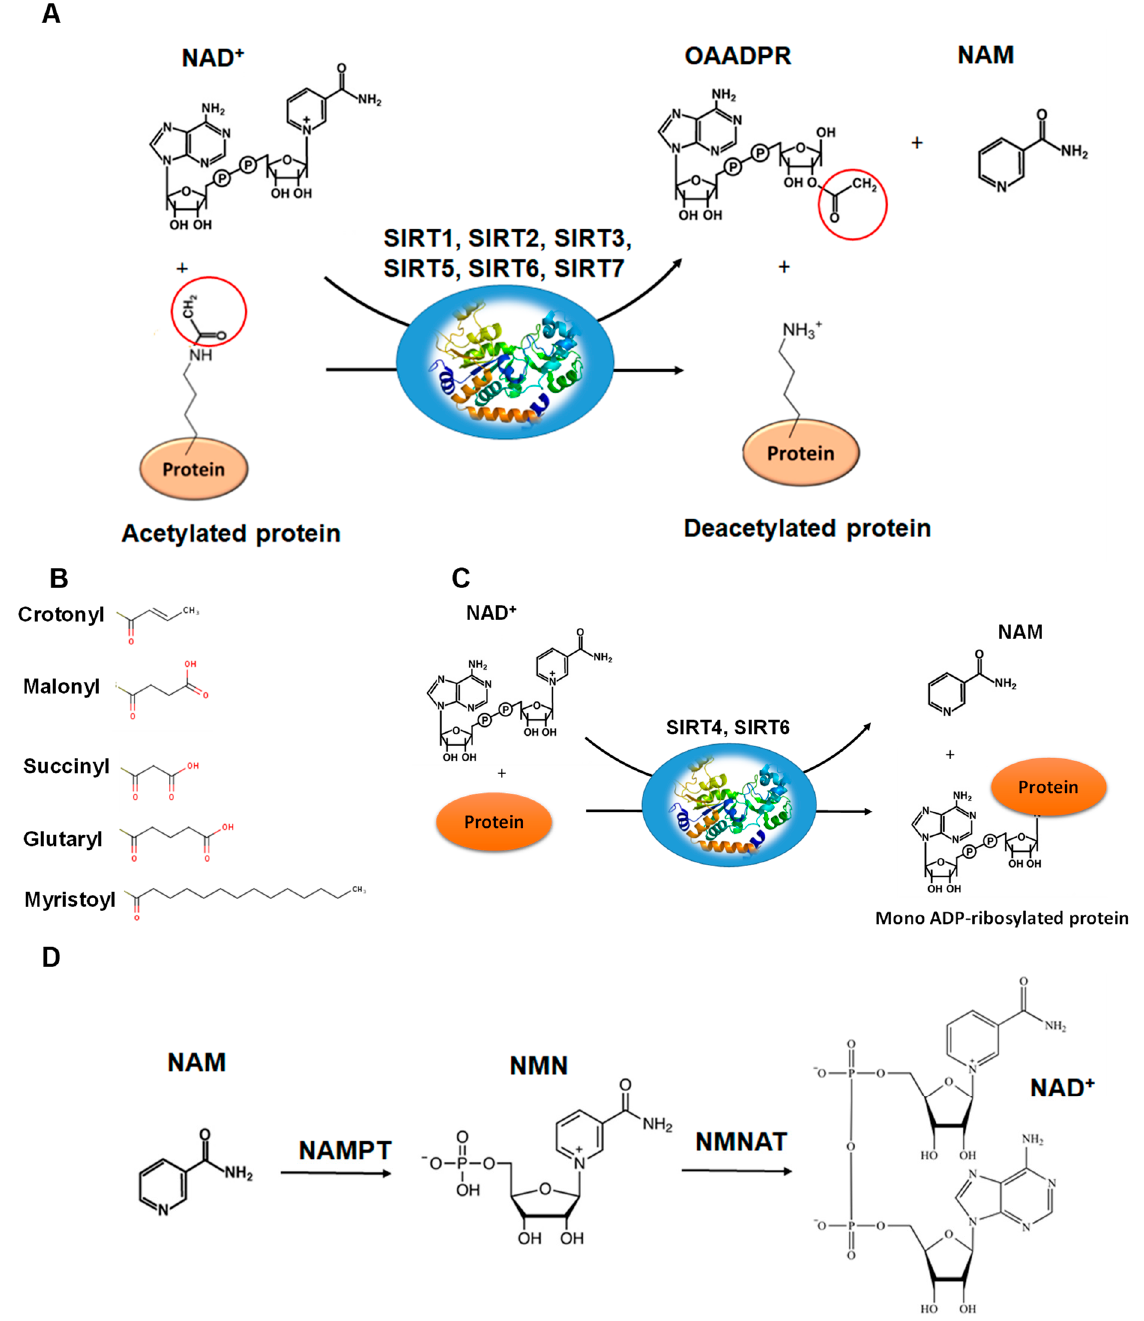
Figure 4. The reactions catalyzed by SIRTs. ( A ) The general deacetylase reaction catalyzed by SIRT1,2,3,5,6,7. The natural substrates are NAD + , water and a protein containing acetylated lysine residue. The reaction products include nicotinamide (NAM), the deacetylated protein and the 2’-O-acetyl-ADPR (OAADPR) molecule. ( B ) Alternative acyl groups that can be deacylated by SIRT3,5,7. ( C ) The ADP-rebosyltransferase activity catalyzed by SIRT4 and SIRT6. ( D ) NAM can be used as precursor for the biosynthesis of NAD + by the enzymes nicotinamide phosphoribosyltransferase (NAMPT) and nicotinamide mononucleotide adenylyltransferase (NMNAT).